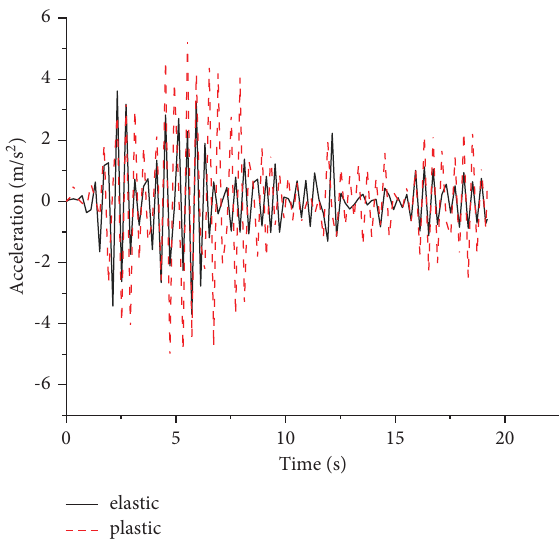
Figure 13: Time-history curve of acceleration in the second span.